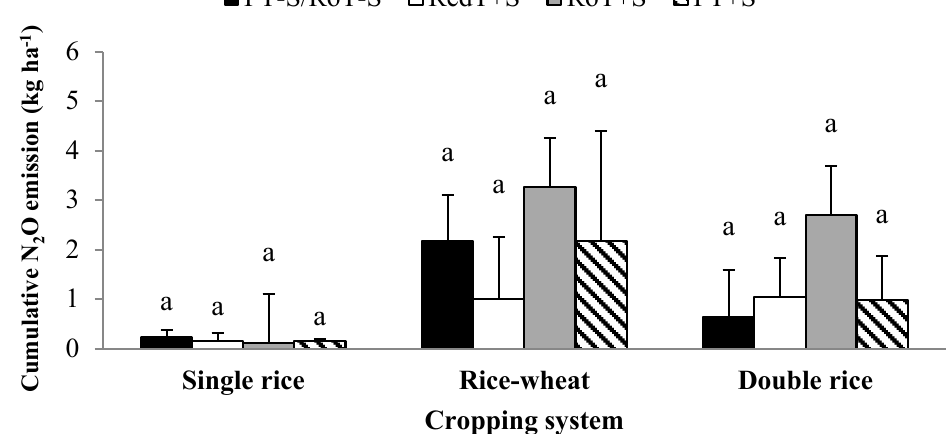
Figure 5. Impacts of straw incorporated tillage patterns on cumulative N 2 O emission Different letters within the same column indicate significant differences among treatments at 0.05 probability level in each cropping system.